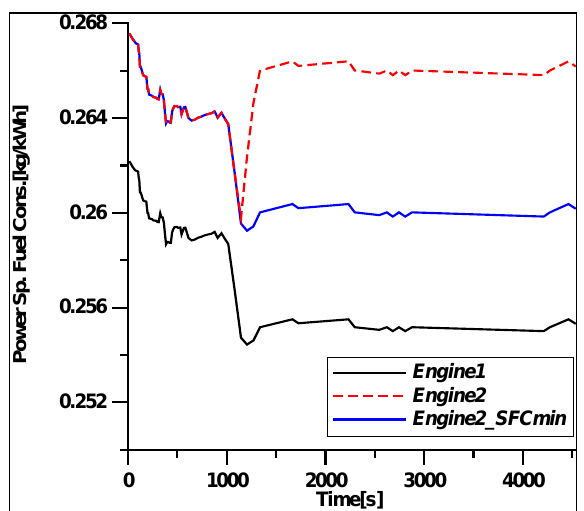
Figure 14. Power vs time of the Engine1 and Engine_2.